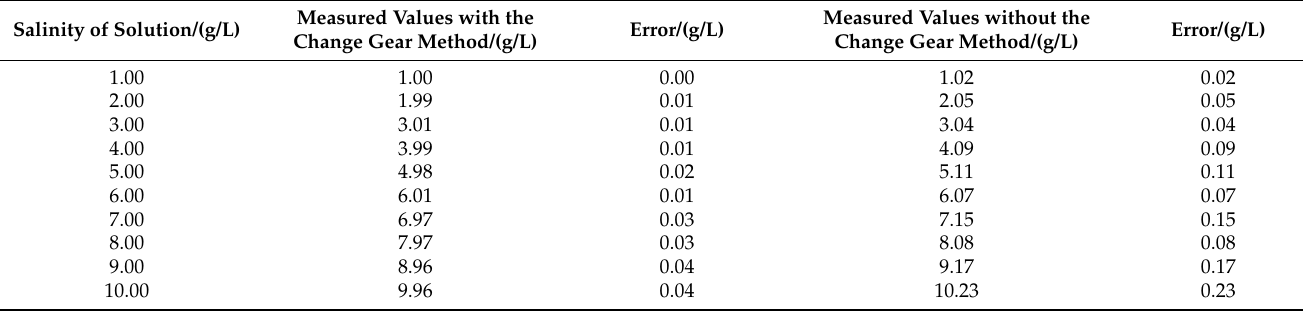
Table 5. Comparison of the experimental